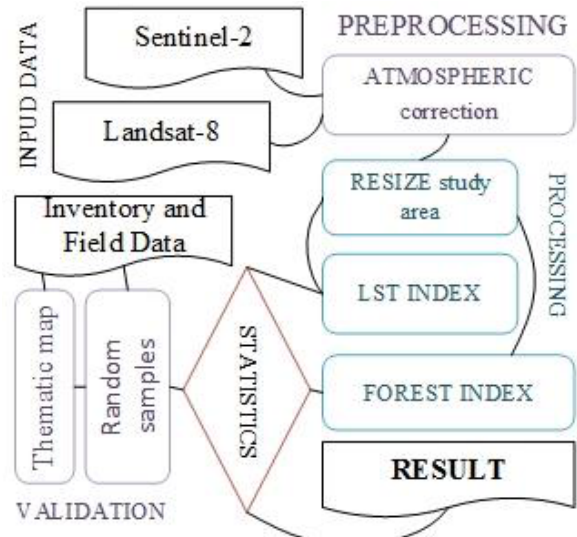
Figure 2. Methodology schema for define forest